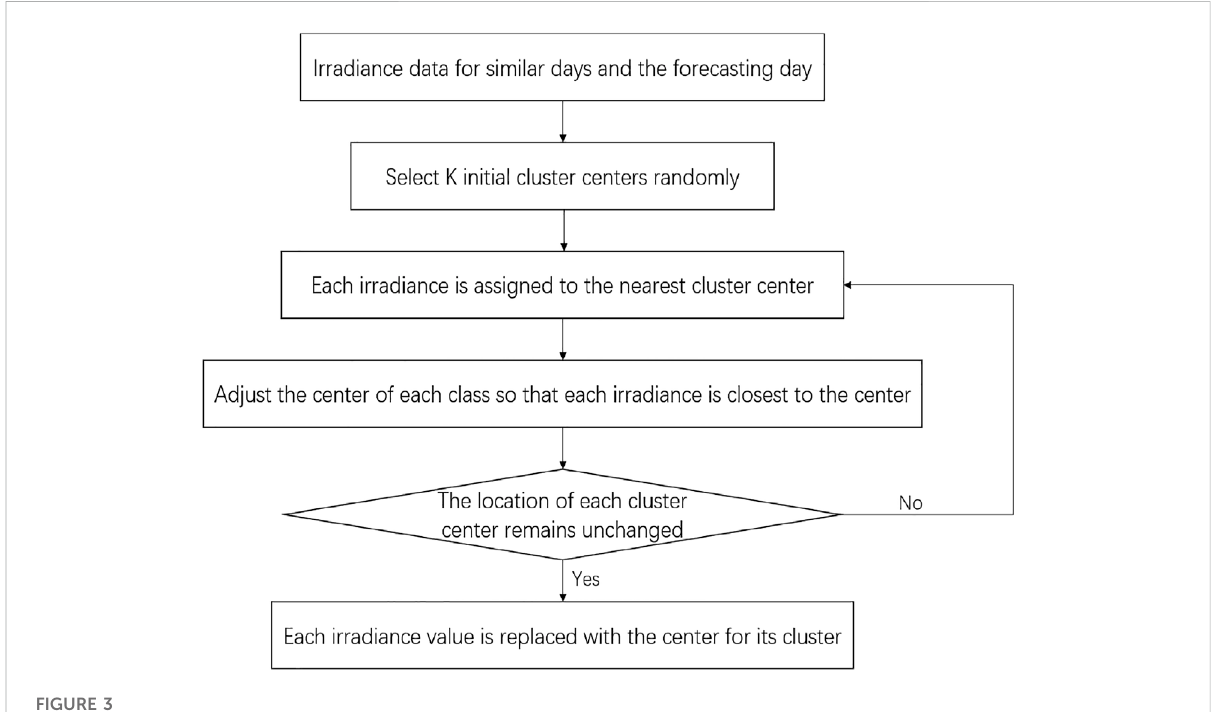
FIGURE 3 The process of the K-means